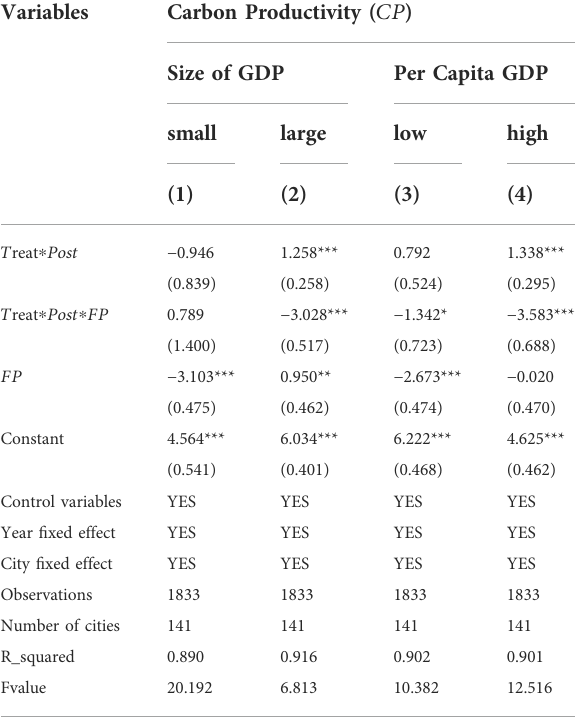
sorted data into two groups: the cities with small GDPs and